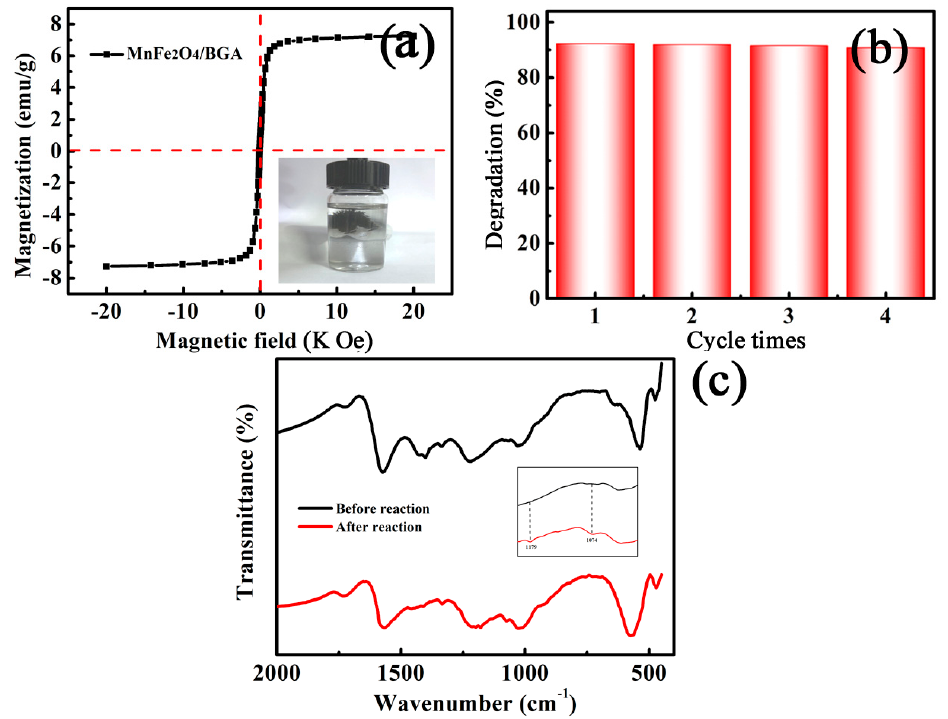
Figure 12. ( a ) The magnetic hysteresis loop of MnFe 2 O 4 /BGA and picture of MnFe 2 O 4 /BGA adsorbed by a magnet; ( b ) Reusability of the MnFe 2 O 4 /BGA composite in 4 successive cycles for the degradation of RhB (MnFe 2 O 4 /BGA − 1.3; catalyst dose: 2 mg, volume of 30% H 2 O 2 : 1.0 mL, [RhB]: 10 mg/L, volume of RhB solution: 50 mL), and ( c ) FT − IR spectra of fresh MnFe 2 O 4 /BGA (in black) and recovered MnFe 2 O 4 /BGA (in